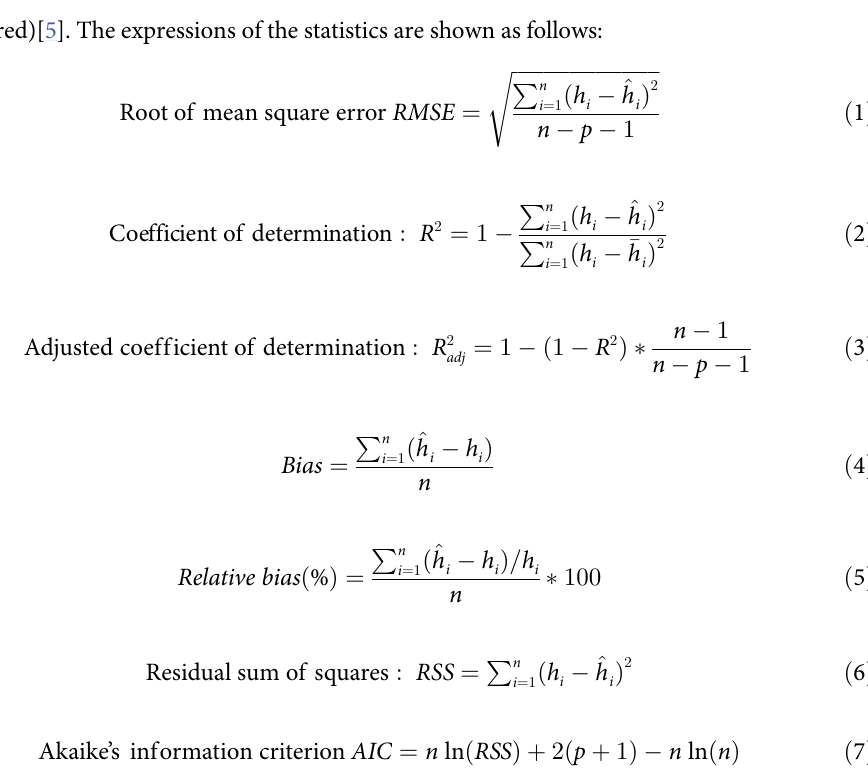
Coefficient of determination : R 2 ¼ 1 (cid:0)